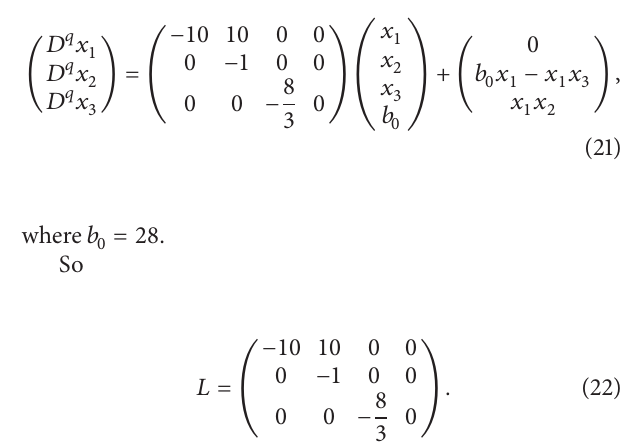
)] = 1 > [Γ(𝑞)] 1/𝑞 = 0.9722 Ω